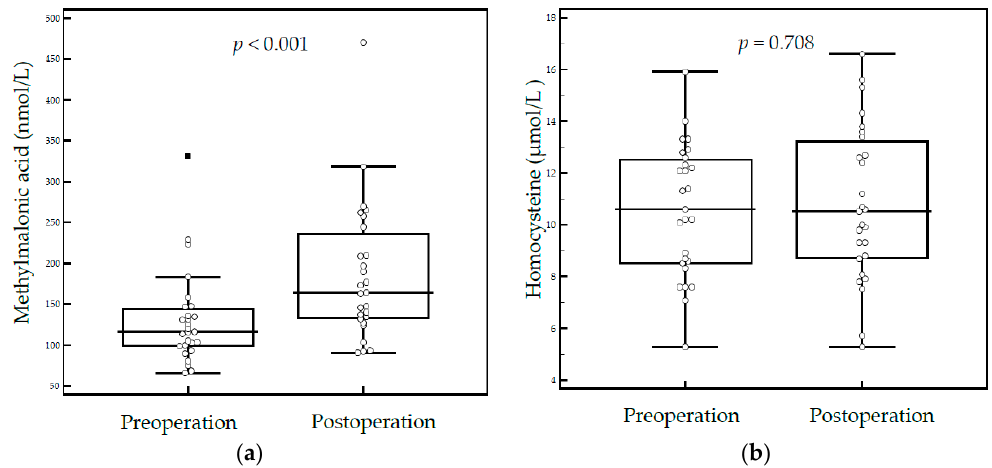
Figure 2. Serum methylmalonic acid ( a ) and homocysteine levels ( b ) in patients before and after Figure 2. ( a ) Serum methylmalonic acid and ( b ) homocysteine levels in patients before and after gastrectomy ( n = gastrectomy ( n = 27).